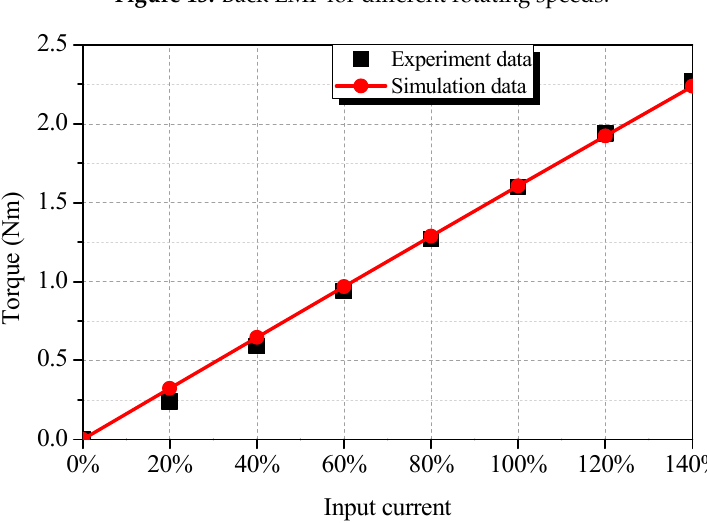
Figure 14. Torque for different input currents.